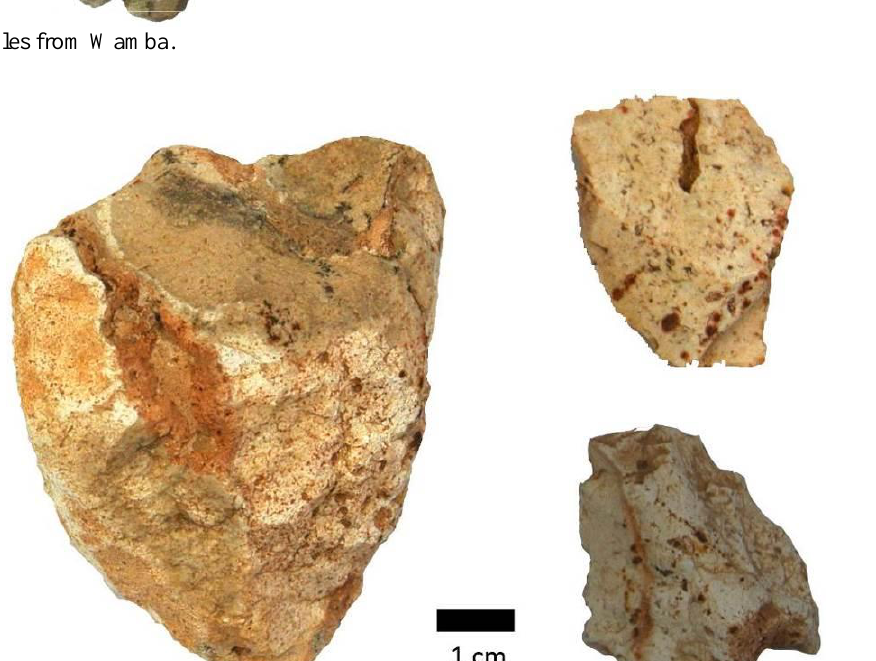
Figure 10. Nodule and pieces from